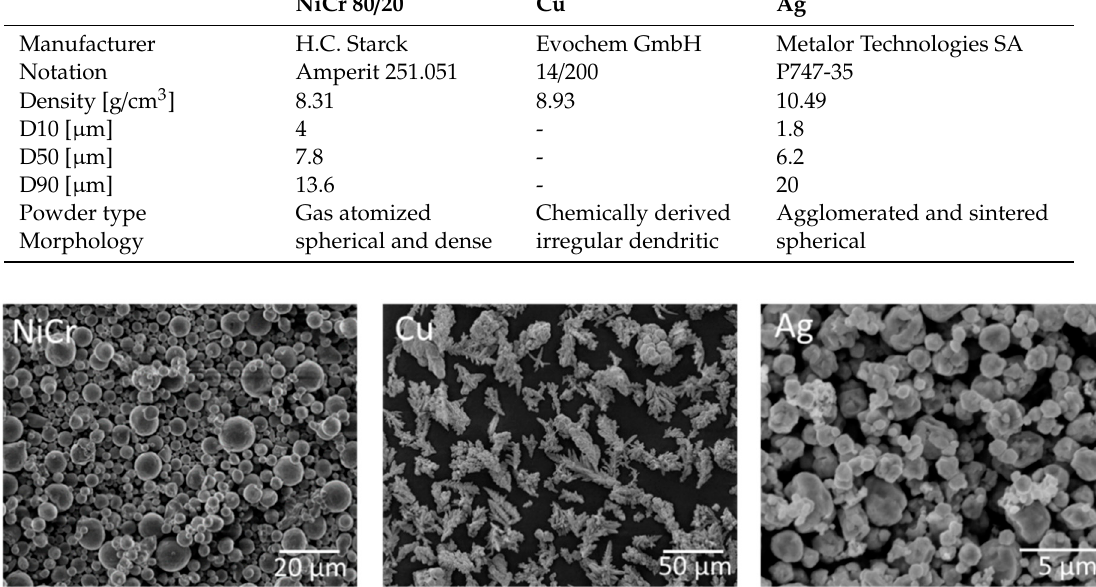
Figure 1. SEM images of the metal powders used in this study.